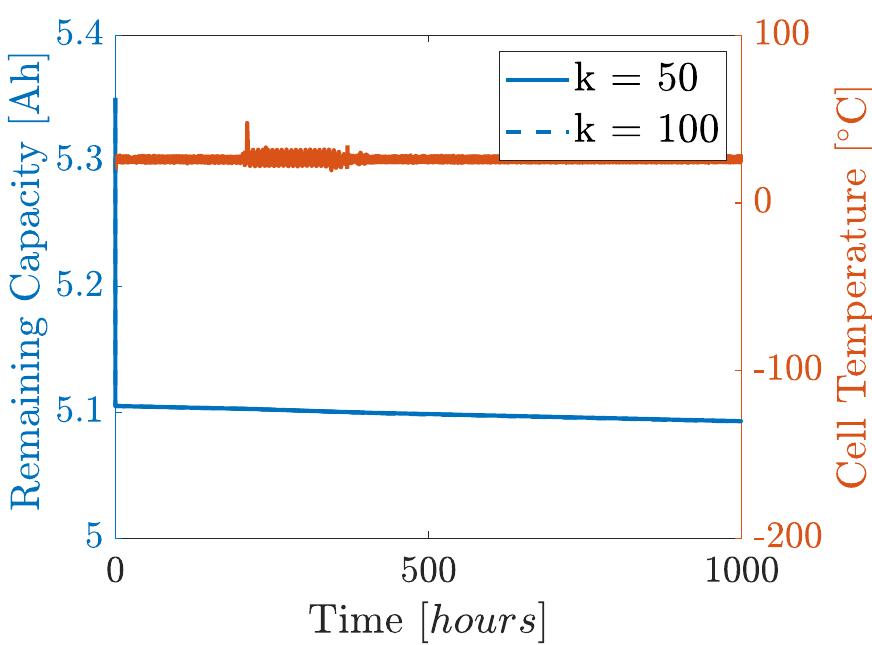
Figure 14. Advanced SoC: Effect of the gain k on Battery